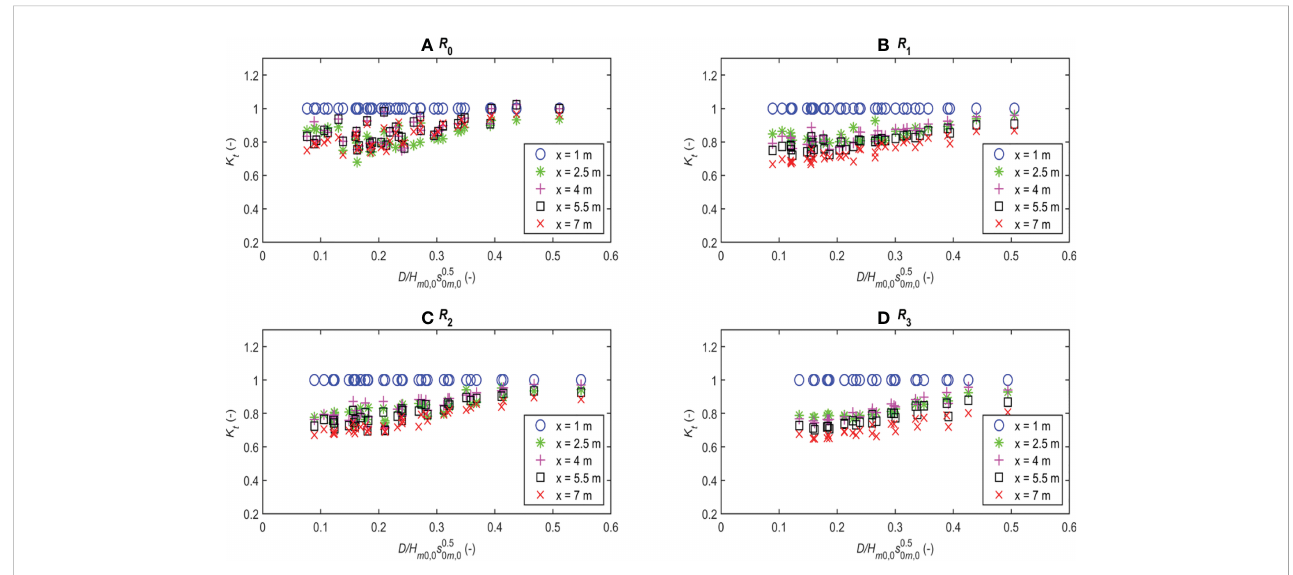
FIGURE 4 Transmission coef fi cient K t versus relative submergence for total waves: (A) Smooth reef; (B) Crushed stone reef 1; (C) Crushed stone reef 2; (D) Simulated coral reef.